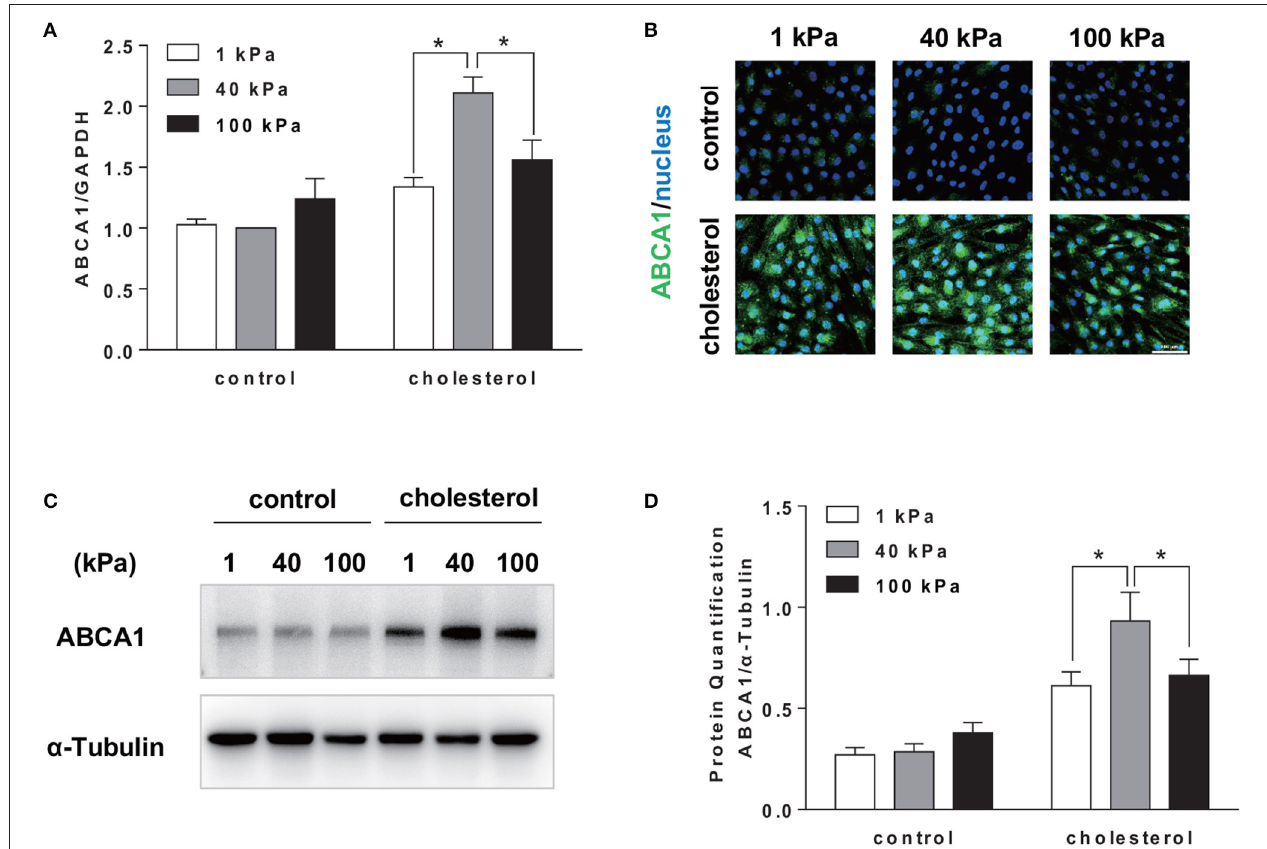
FIGURE 4 | Substrate stiffness affected cholesterol accumulation in SMCs by regulating cholesterol efflux through ABCA1. SMCs were seeded on substrate with different stiffness and treated with 20 µ g/ml Chol: M β CD for 72 h. SMCs without treatment were used as control. (A) ABCA1 gene expression level was measured by RT-qPCR. GAPDH was used as the internal control for normalization ( n = 3). (B) ABCA1 (green) expression in SMCs cultured on substrate with different stiffness without (control) or with cholesterol treatment (blue: DAPI staining of the nucleus, scale bar = 100 µ m). (C,D) ABCA1 protein expression level was analyzed by Western blotting analysis. The expression of α -Tubulin was used as the internal control. Quantitation of the protein expression was calculated as the ratio of target protein to α -Tubulin ( n = 3). ∗ p <